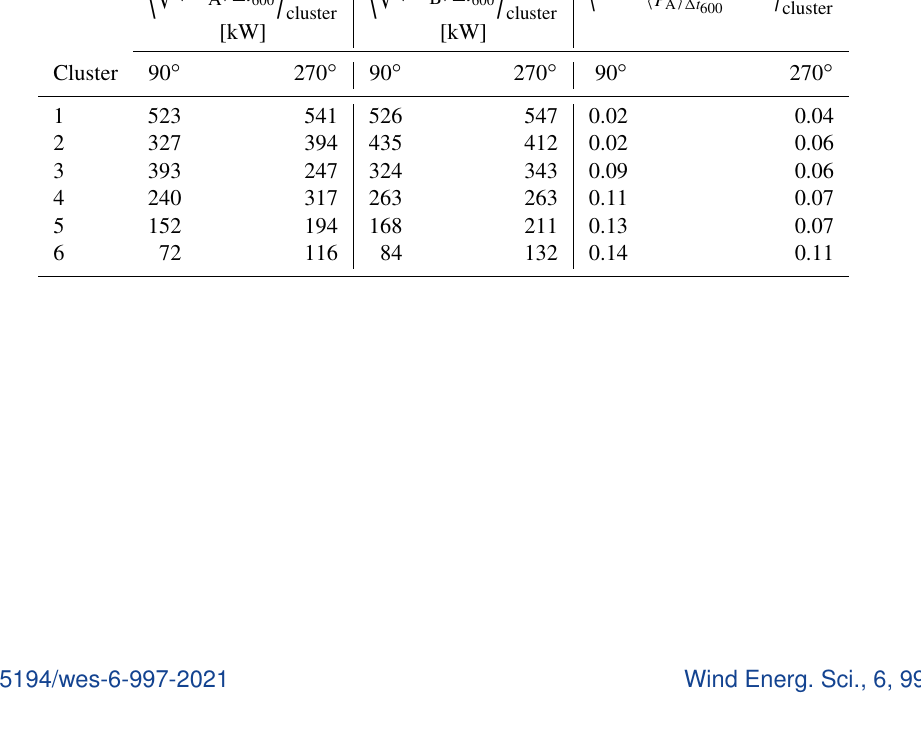
(cid:113) (cid:104) P (cid:48) 2 (cid:105) (cid:49)t is the standard deviation of the power output fluctuations of wind turbine A A 600 and (cid:104) P B (cid:105) (cid:49)t are the average 600 600